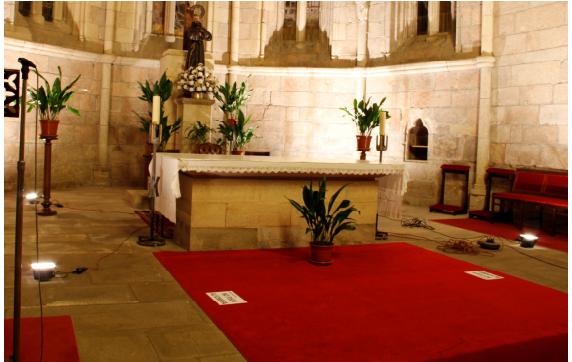
Figure 4. Lighting conditions settings (detail).